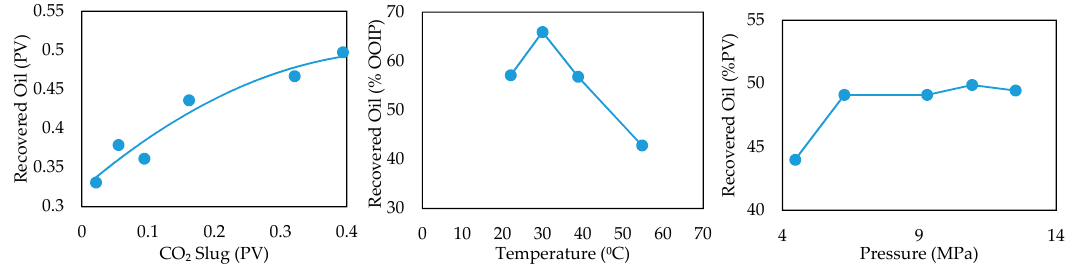
Figure 4. Effects of reservoir and injecting CO 2 properties on oil recovery